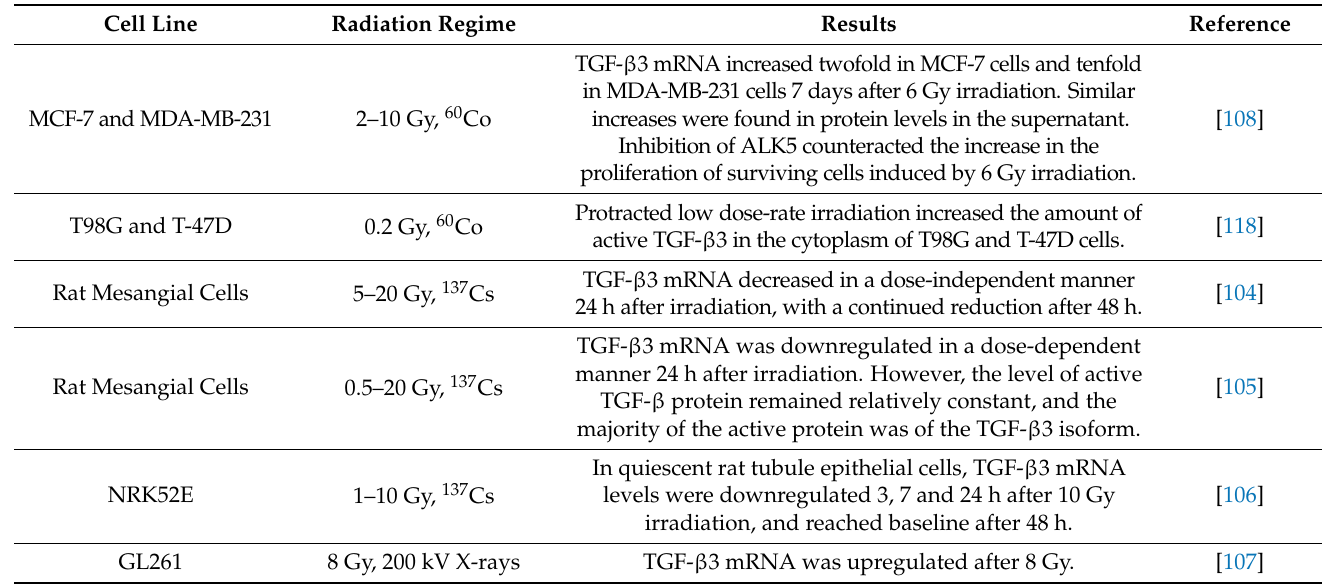
Table 1. Studies of endogenous transforming growth factor-beta 3 (TGF- β 3) expression after irradia- tion in vitro. ALK: activin-like kinase.